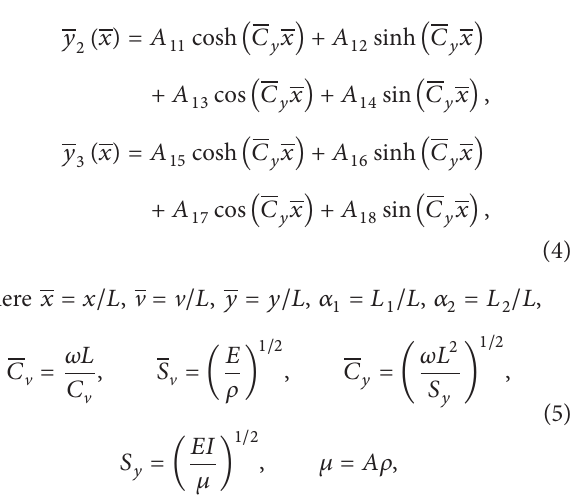
Figure 3: Relative crack depth (𝛽) versus dimensionless compliance )) (( ln ( 𝑆 𝑖=1,2𝑗=1,2